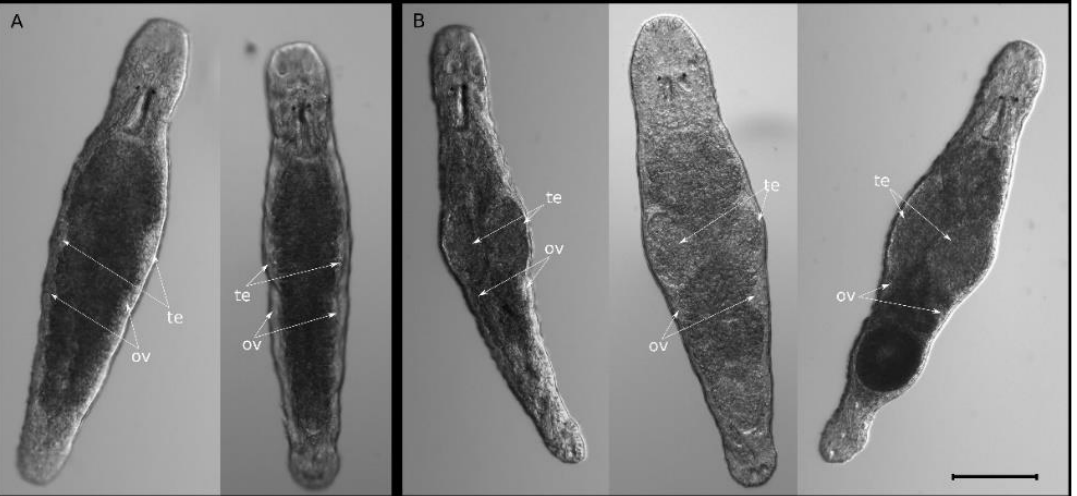
Figure 1. Mlig-SKP1 RNAi leads to enlarged testes in M. lignano . Live worm images are shown. ( A ) Control animals treated with dsRNA against GFP . ( B ) Animals treated with dsRNA against Mlig-SKP1 . Scale bar is 150 µm. Te — testes, ov — ovaries.